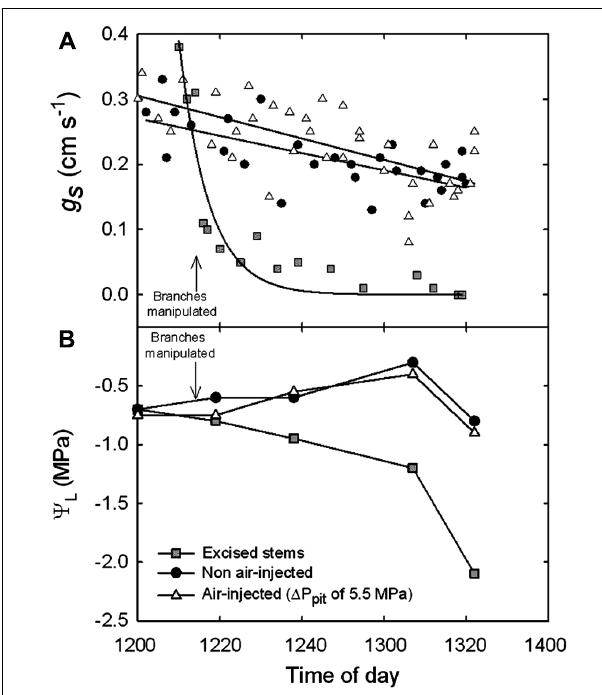
FIGURE 4 | (A) Stomatal conductance ( g s ) measured on A. rubrum leaves attached to stems before and after pneumatic pressurization treatment with (cid:2) P pit of 5.5 MPa (triangles) compared to non-injected control branches (circles) and from excised branches (squares). (B) Xylem pressure potentials ( Ψ xp ) measured from leaves covered in plastic bags that were attached to controls and manipulated branches during the experiment.